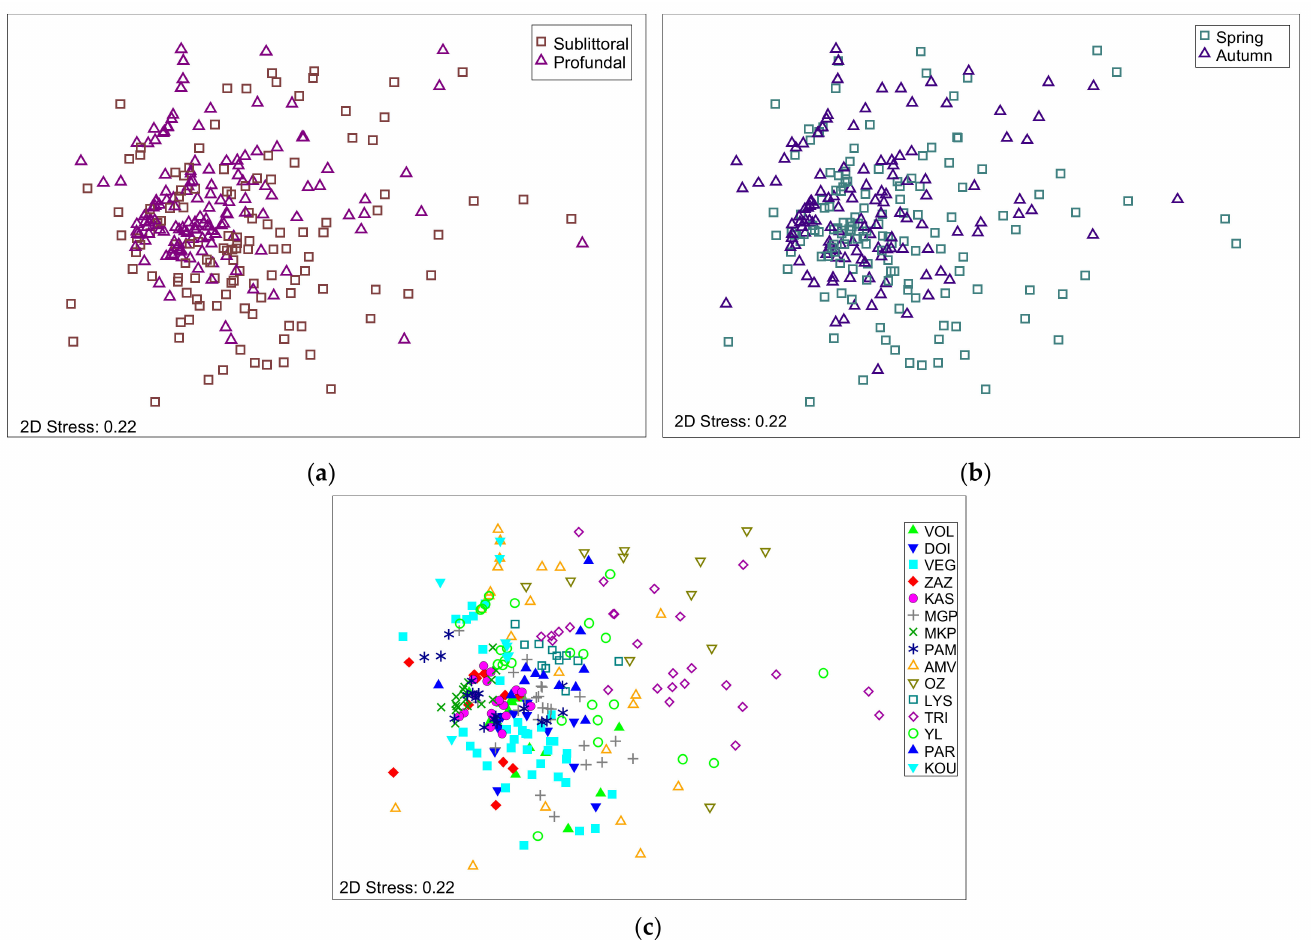
Figure 3. Non-metric multidimensional scaling (MDS) plot of the benthic macroinvertebrate community composition between ( a ) lake zones (sublittoral and profundal); ( b ) seasons (spring and autumn); and ( c ) among lakes in the studied